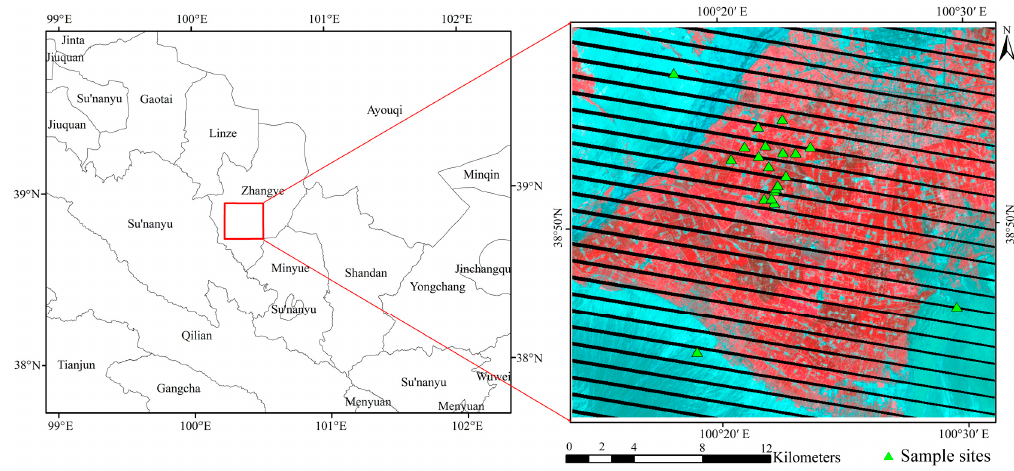
Figure 1. Study area and spatial distribution of the field measurement sites (The field measurement sites were not located in the black stripes).